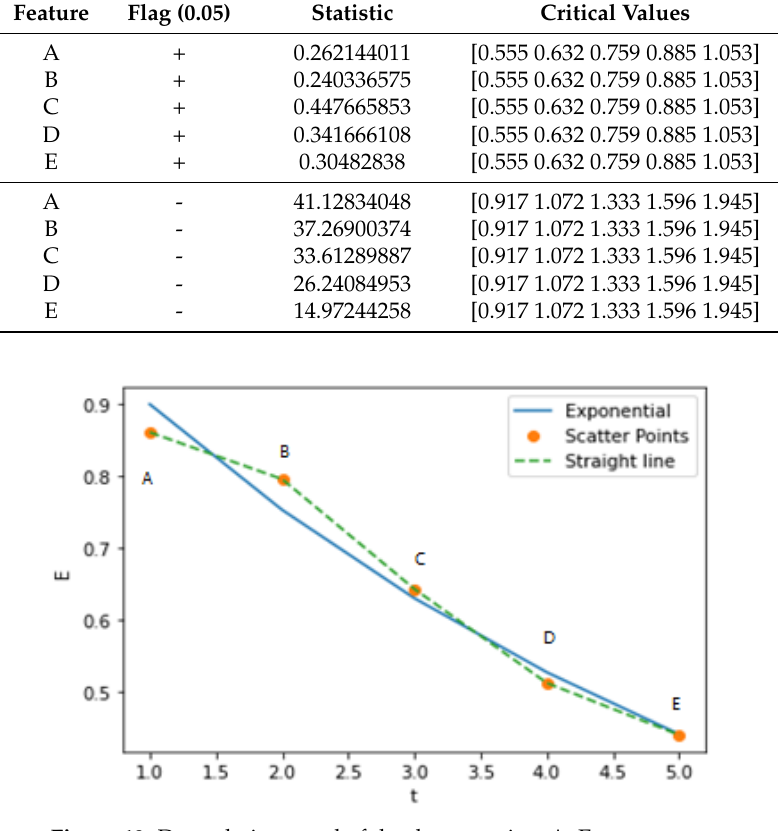
Figure 13. Degradation trend of the data at points A–E.